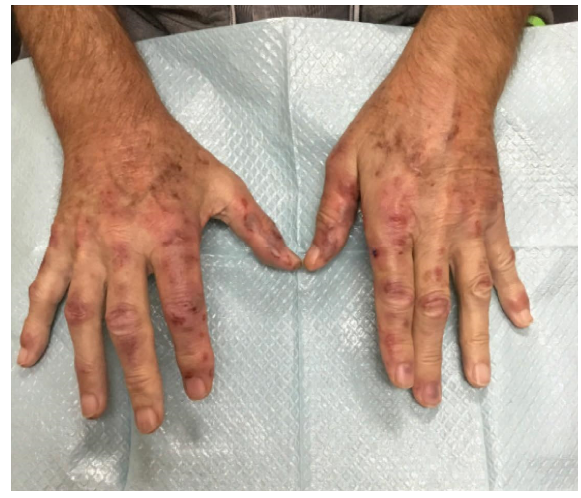
Figure 3: Rash at one week